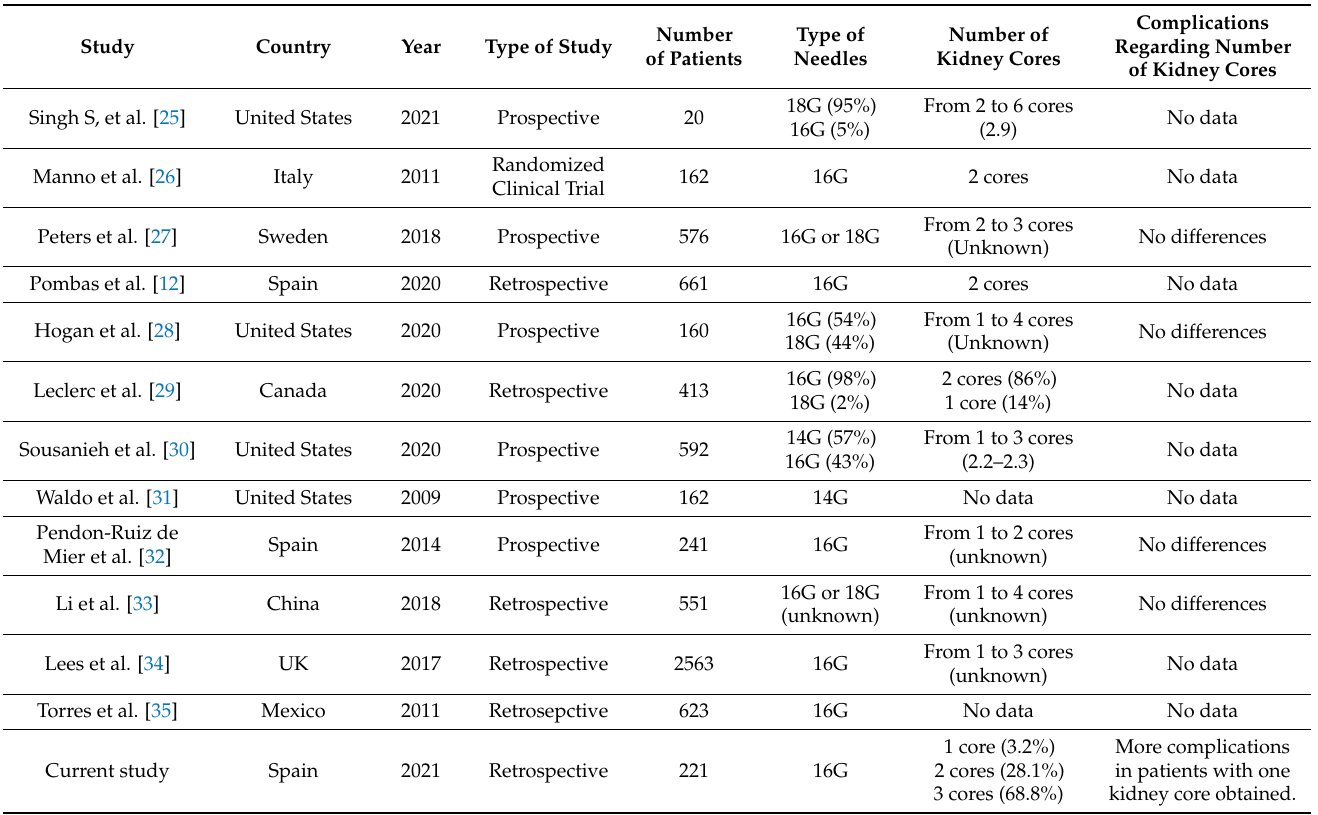
Table 7. Principal studies for kidney biopsy complications, including technical